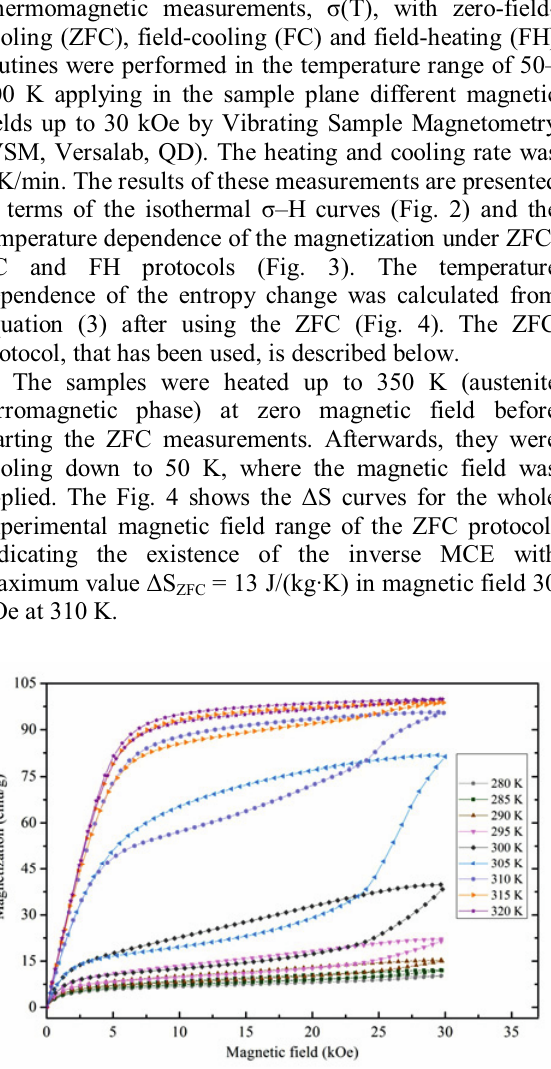
Figure 2. The isothermal magnetization curves at different temperatures, showing the magnetic-field-induced martensitic transformation.